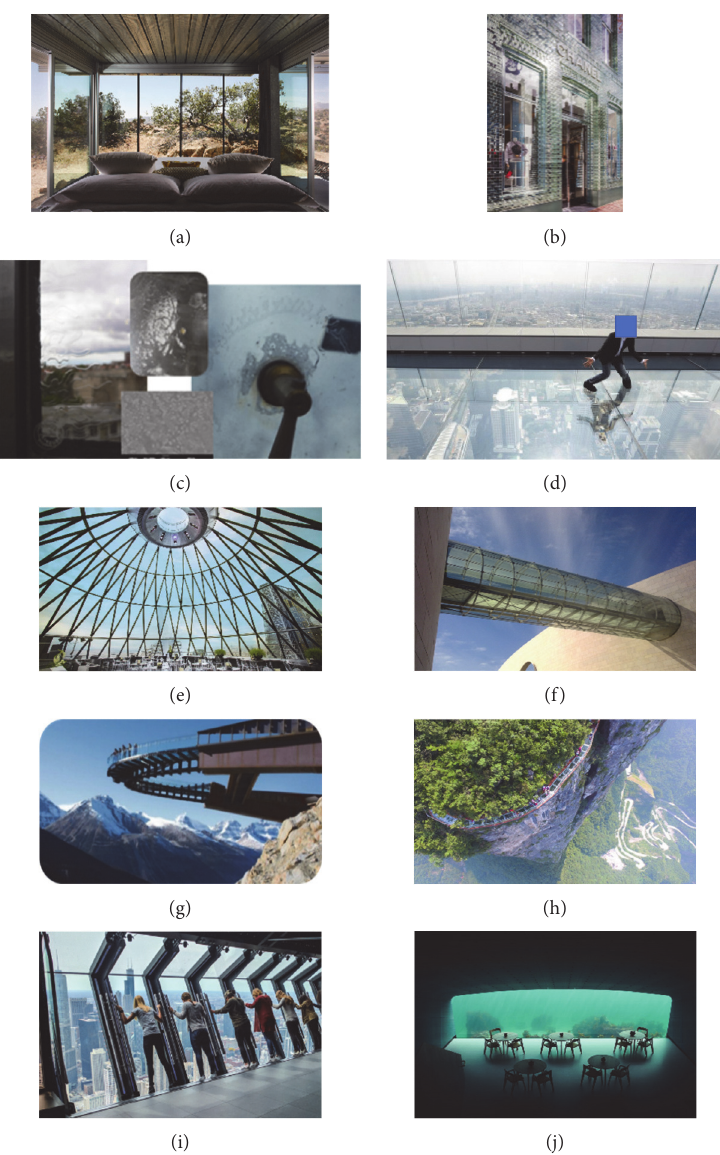
Figure 14: Static input items: (a) private room (Off-grid itHouse, Pioneertown, USA; © Airbnb); (b) glass bricks (Chanel Amsterdam Store, NL, © MVRDV); (c) delamination (reproduced from [48] under the terms and permissions of a CC-BY license); (d) skywalk (Mahanakhon, Bangkok, THA, © Tripadvisor); (e) roof (30St Mary Axe Tower, London, UK, © ArchDaily); (f) footbridge (glass bridge, Lisbon, PT, © Schlaich Bergermann Partner, DE); (g) skywalk (Jasper National Park, CA, © Getty Images); (h) walkway (Cliffside skyway, CN, © Global Times); (i) observation deck (360 Chicago Tilt, Chicago, USA, © Tripster); (j) underwater restaurant (N) © Dezeen. (a) Item #5; (b) item #7; (c) item #9; (d) item #13; (e) item #14; (f) item #17; (g) item #18; (h) item #22; (i) item #23; (j) item #26.